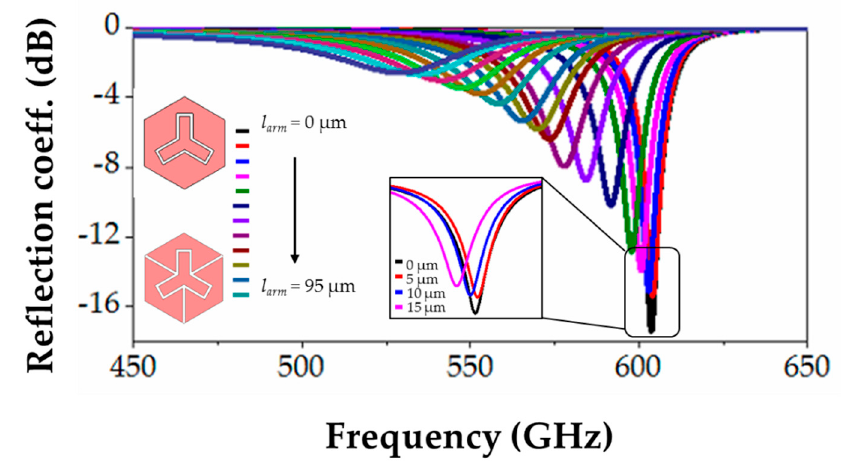
Figure 3. Reflection coefficient for different arm lengths (linear sweep from 0 to 95 μ m) of the hollow tripod structure. Insets: schematic representation for arm lengths of 0 μ m (top) and 95 μ m (bottom).